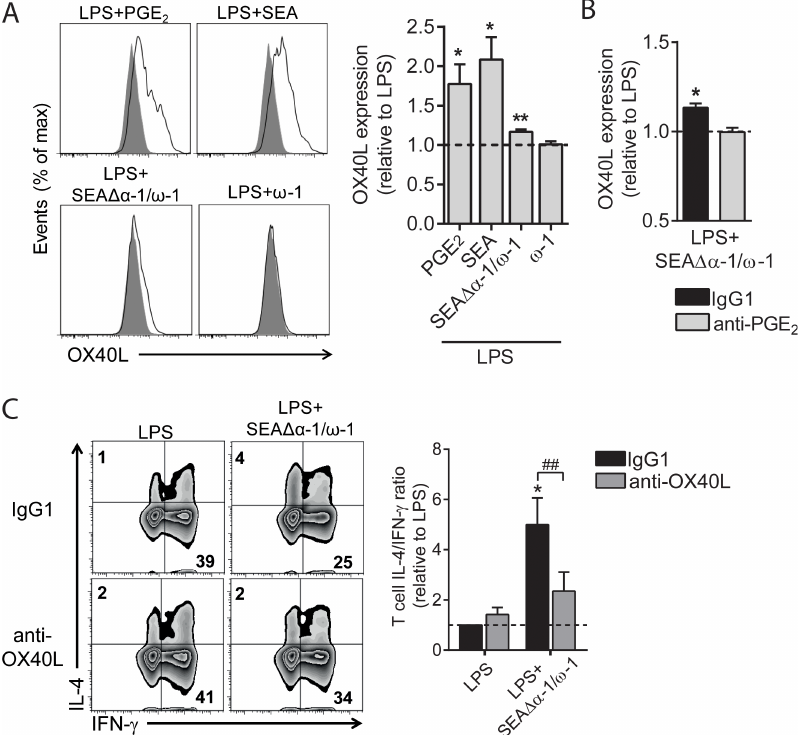
Fig 3. OX40L is induced by SEA via PGE 2 signaling and is required for Th2 induction. (A, B) moDCs were stimulated as indicated for 48 h in the presence or absence of neutralizing anti-PGE 2 antibody, after which expression of OX40L was analyzed by flow cytometry. The fold change based on geometric mean fluorescence is shown relative to LPS, which is set to 1 (dashed line). (A) PGE 2 was taken along as positive control for OX40L expression and a representative histogram plot of OX40L expression is shown on the left. (C) T-cell polarization assay as described in Fig 2C. Neutralizing OX40L antibody was added during the DC–T cell coculture. Bar graphs represent means ± SEM of at least 6 independent experiments. “ (cid:3) ”: P < 0.05: “ (cid:3)(cid:3) ” and “##”: P < 0.01 for significant differences with the control conditions ( (cid:3) ) or between-test condition (#) based on paired analysis (paired Student t test). Underlying data can be found in S1 Data. DC, dendritic cell; LPS, lipopolysaccharide; moDC, monocyte-derived DC; OX40L, OX40 ligand;